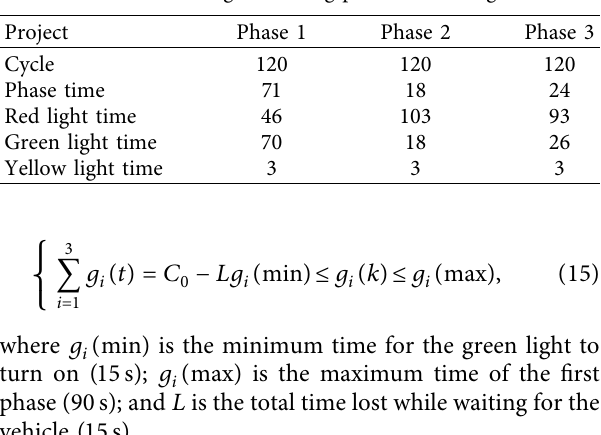
Figure 1: Intersection of Guangzhi Road and Nanhua Road. Table 1: The original timing plan of traffic